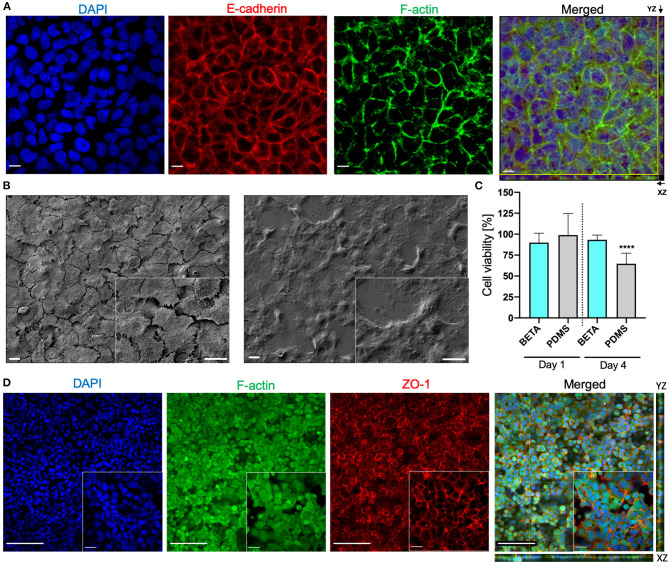
Bioactivity of the BETA membrane (optimum: 9.35% PCL and 6.34% gelatin [w/v of TFE]). (A) Z-stack Confocal Laser Scanning Microscopy (CLSM) of human alveolar epithelial cells (A549) on the membrane (under static submerged culture conditions for 6 days) demonstrating the formation of a confluent uniform cell layer. The cell nuclei (DAPI, blue), expression of the cell-cell adhesion protein E-cadherin (red), and formation of F-actin filaments (green). The scale bar is 10 μm. (B) SEM image of A549 cells after proliferation on a (left) biphasic membrane and (right) a commercial Transwell® insert (6 days of submerged culture). The scale bar is 10 μm. (C) Effect of leaching from BETA and PDMS membrane on cell viability (WST1 assay; A549 cells). BETA and PDMS membranes were incubated for 2 days in cell culture medium and this medium was used to grow A549 cells for 1 and 4 days in a standard 12-well tissue culture well plate. The reduced cell viability for PDMS-conditioned medium after 4 days indicates that some substances (e.g., uncured oligomers) leaching from the PDMS have a cytotoxic effect. This effect is not seen for the BETA membrane. The viability data were normalized that of a standard 12- well cell culture plate with fresh medium. Data are reported as mean ± SD. n = 8; ****P < 0.00001 by one-way ANOVA with Dunnett test. (D) Z-stack and orthogonal CLSM view of (XY) with side views of YZ (right) and XZ (bottom) optical projection of the human bronchial epithelial cells (16HBE14o−) on the membrane visualizing a confluent cell monolayer and the formation of tight junctions (culture conditions: 6 days submerged and 24 h ALI culture); cell nucleus (DAPI, blue), F-actin filaments (green); ZO-1 tight junction (red). The scale bars are 100 μm (for the 20× projection view) and 20 μm (for the 63× projection view).